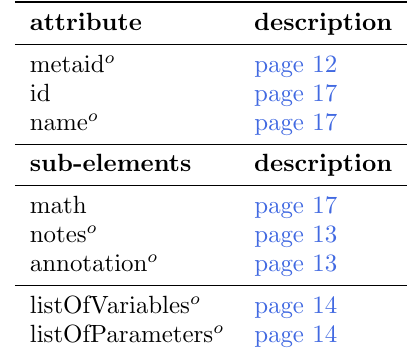
Each instance of the DataGenerator class is identifiable within the experiment by its unambiguous id .